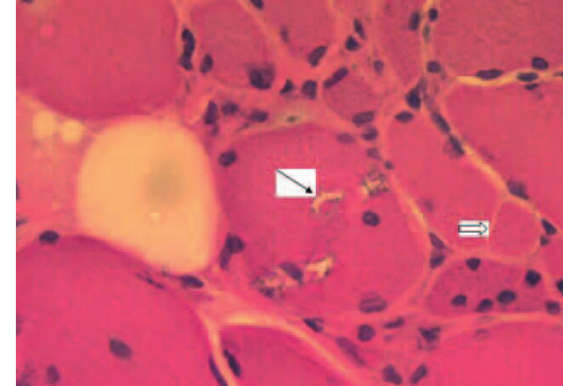
Figure 2. Histological picture of IBM. Characteristic cytoplasmatic basophilic rimmed vacuoles can be observed (black arrow) and fi ber splitting (white arrow). (HE; 400x)